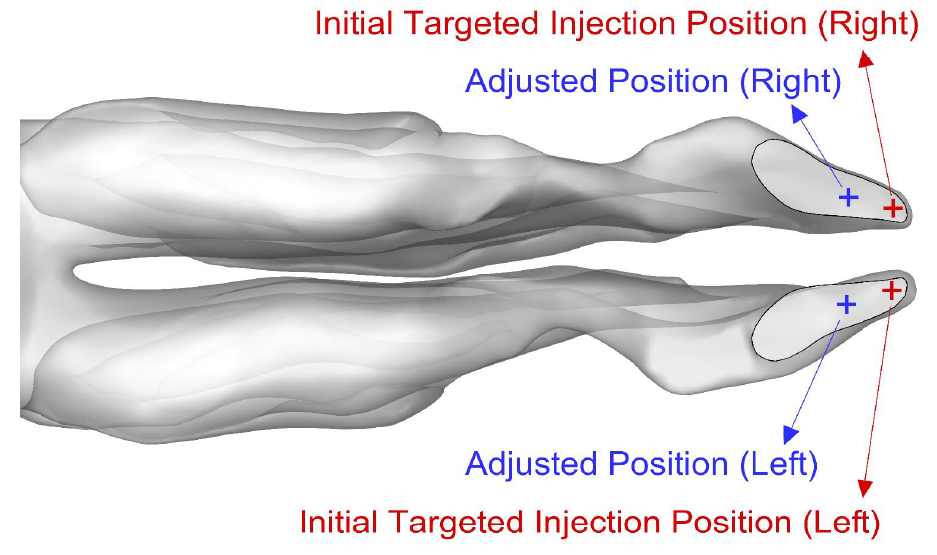
Figure 8. Initial and adjusted positions for targeted